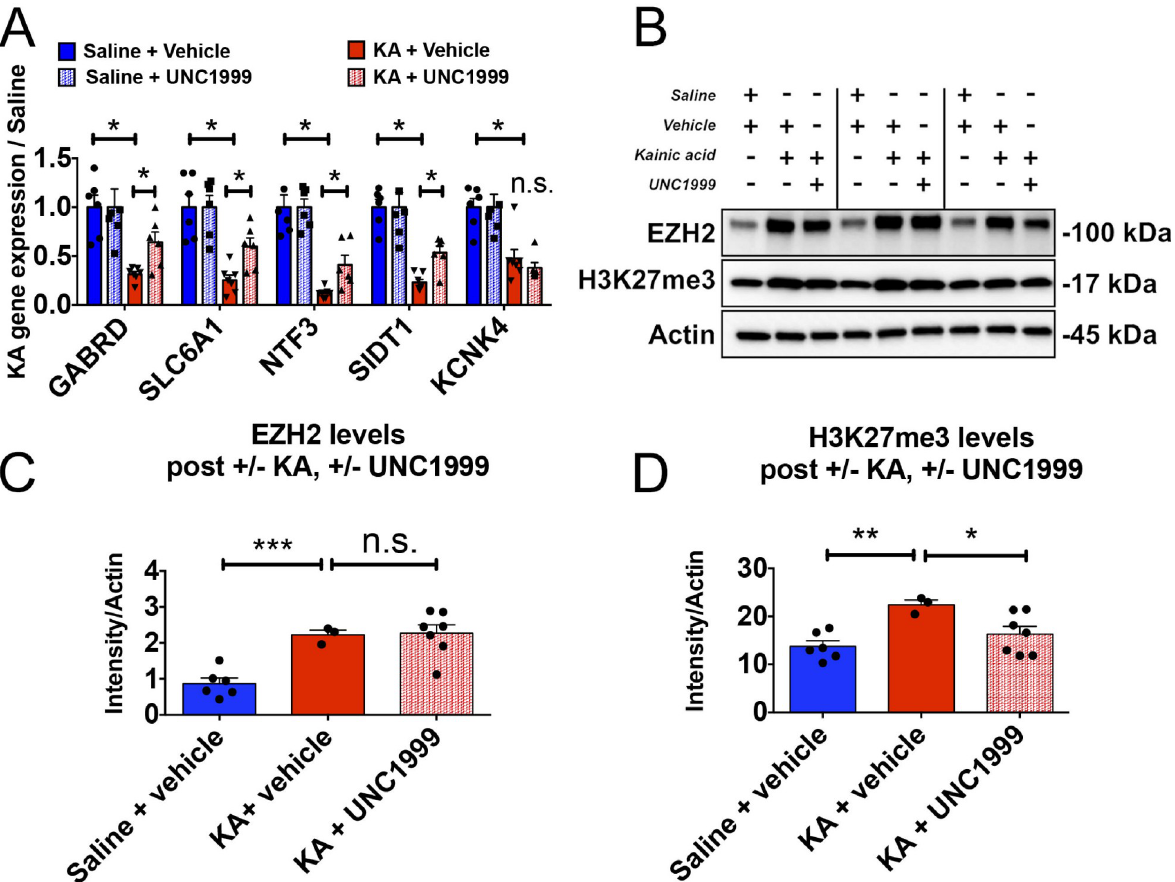
Fig 7. UNC1999 treatment three days in vivo is sufficient cause functional changes in EZH2 target gene expression and H3K27me3 levels. (A) Schematic demonstrating how tissue was harvested to assess EZH2 target gene expression levels post UNC1999 treatment. B) Expression levels of EZH2 target genes are de-repressed after treatment with UNC1999 (multiple t-tests, p < 0.05, with Holm-Sidak correction). (C) EZH2 protein levels do not change eight days after UNC1999 treatment. (D) Increased H3K27me3 levels detected at 10 days in KA + vehicle treated animals are reduced with treatment of UNC1999. Statistical significance assessed by Student’s unpaired t-test with equal SD (p < 0.05), n = 6 saline + vehicle, n = 3 KA + vehicle and n = 7 KA + UNC1999 animals. � p < 0.05, �� p < 0.01, ��� p < 0.001, ���� p < 0.0001.